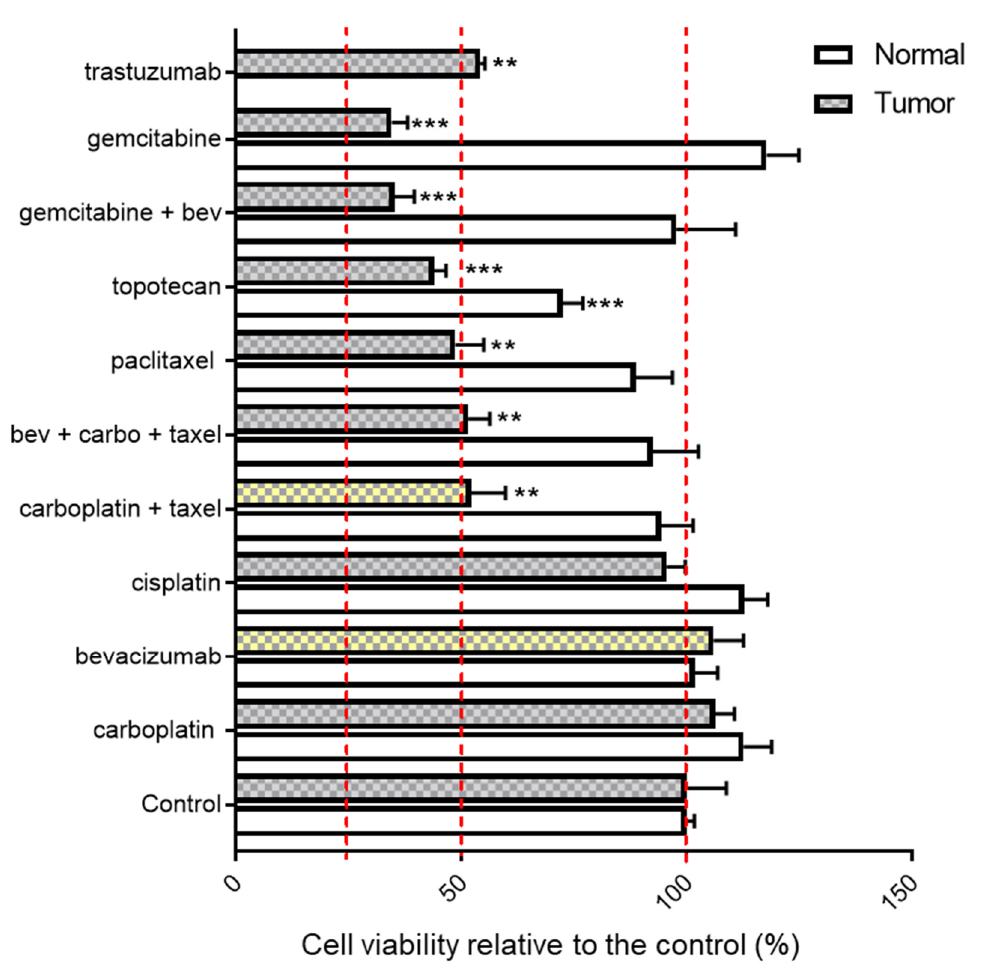
Figure 4. Varying drug sensitivity to the standard and alternative therapeutic options for the ONC-6057 PDO. Waterfall plot of the patient’s (ONC-6057) tumor organoid drug sensitivity with the paired normal uterine drug sensitivity. The cytotoxic agents in the chemotherapy regimen (carboplatin + paclitaxel and bevacizumab) the patient received after resistance to trastuzumab was observed are highlighted in yellow. The change in viability was calculated relative to the control which was set at 100% (i.e., no cell death). Statistical significance was assessed by ordinary one-way ANOVA with Tukey’s multiple comparison test; ** p < 0.01, *** p < 0.001 vs. the paired control (normal or tumor specimen).